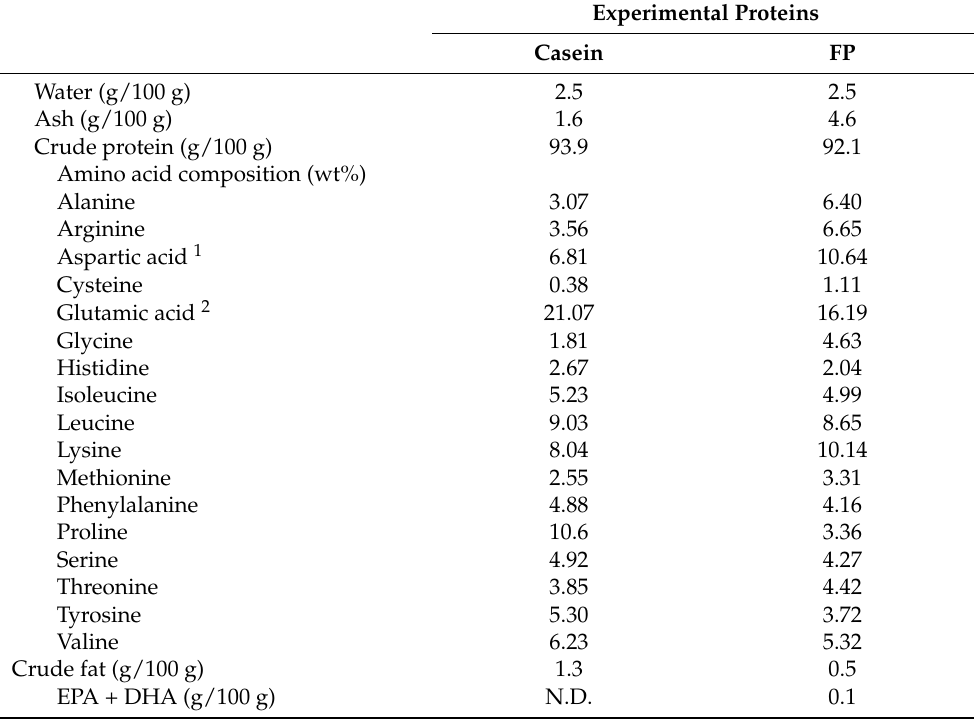
Table 1. Nutritional and amino acid composition of casein and fish protein (FP).